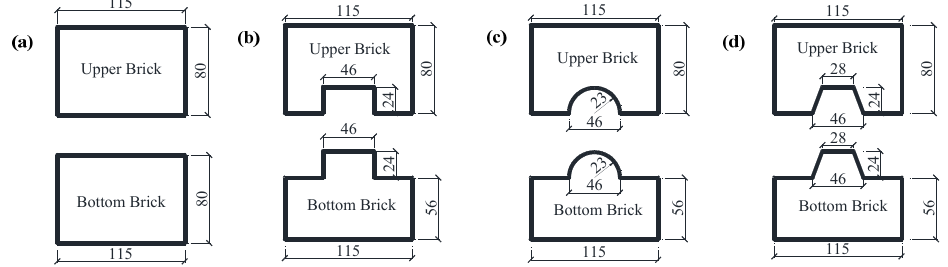
Figure 3. Dimensions and profiles of the cross ‐ section for specimens of bricks with various interlocking shapes: ( a ) non ‐ interlocking; ( b ) rectangular interlocking; ( c ) circular interlocking; ( d ) trapezoidal interlocking. (Units: mm).